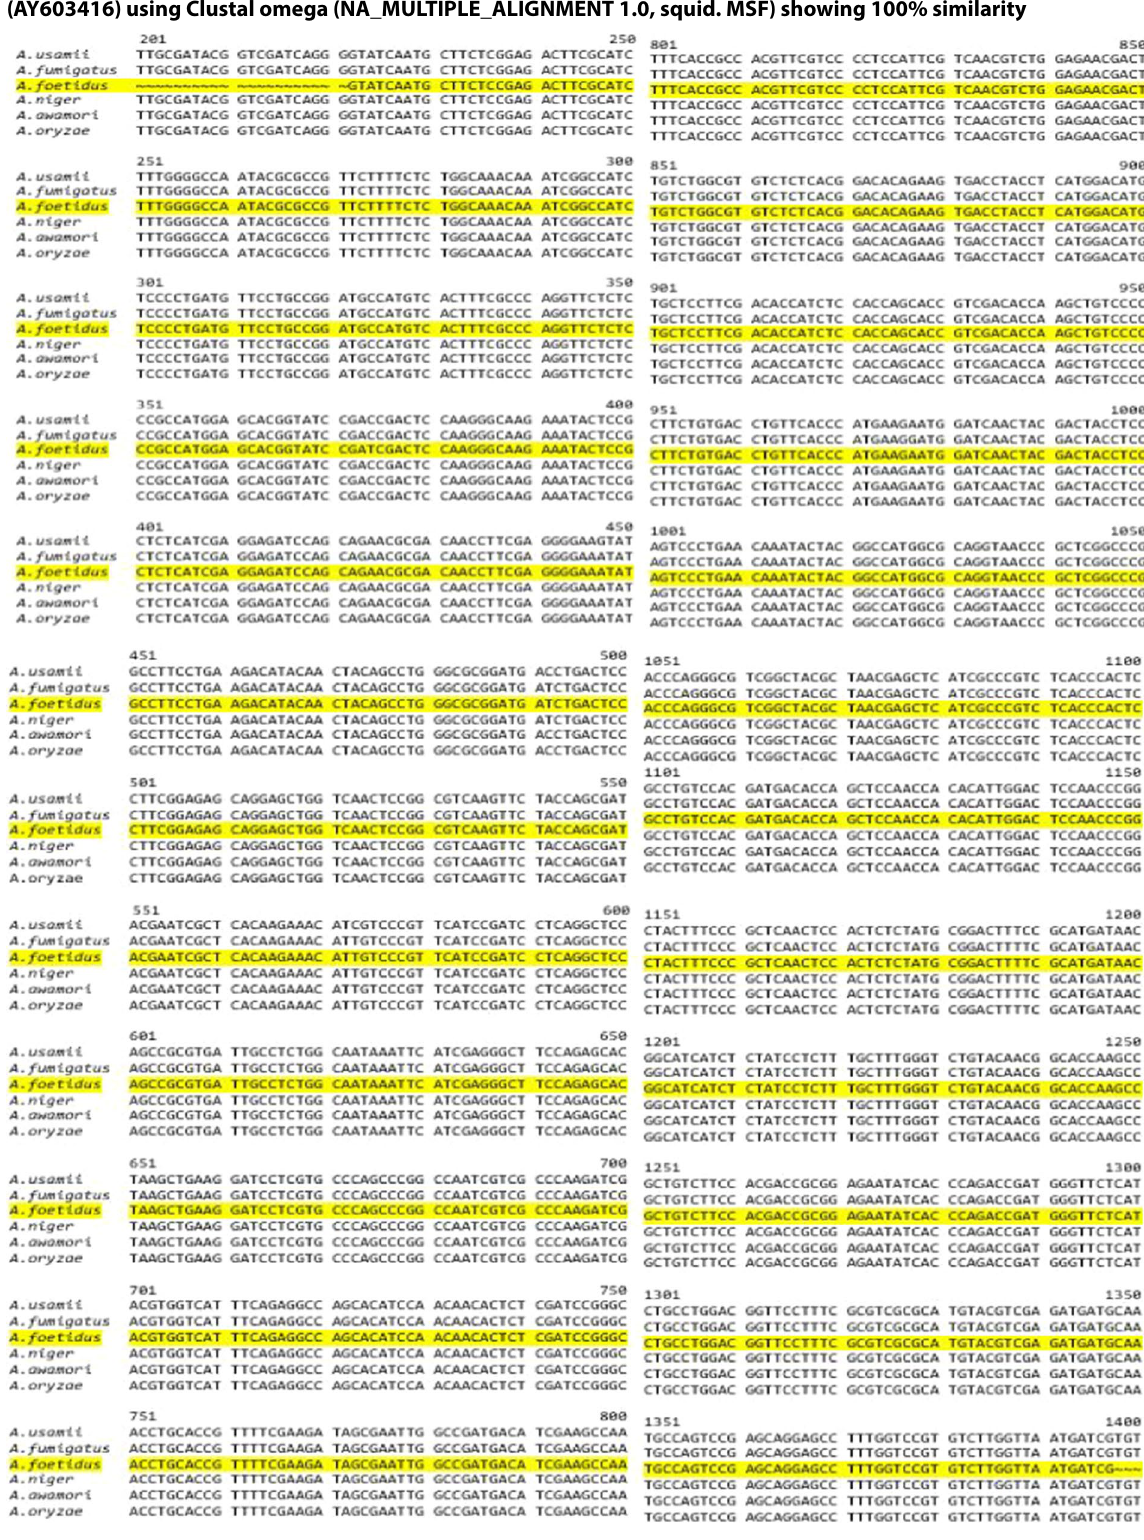
Table 2 Nucleotide sequence of A. foetidus MTCC 11682 (Acc. No. KY307787) was compared with other